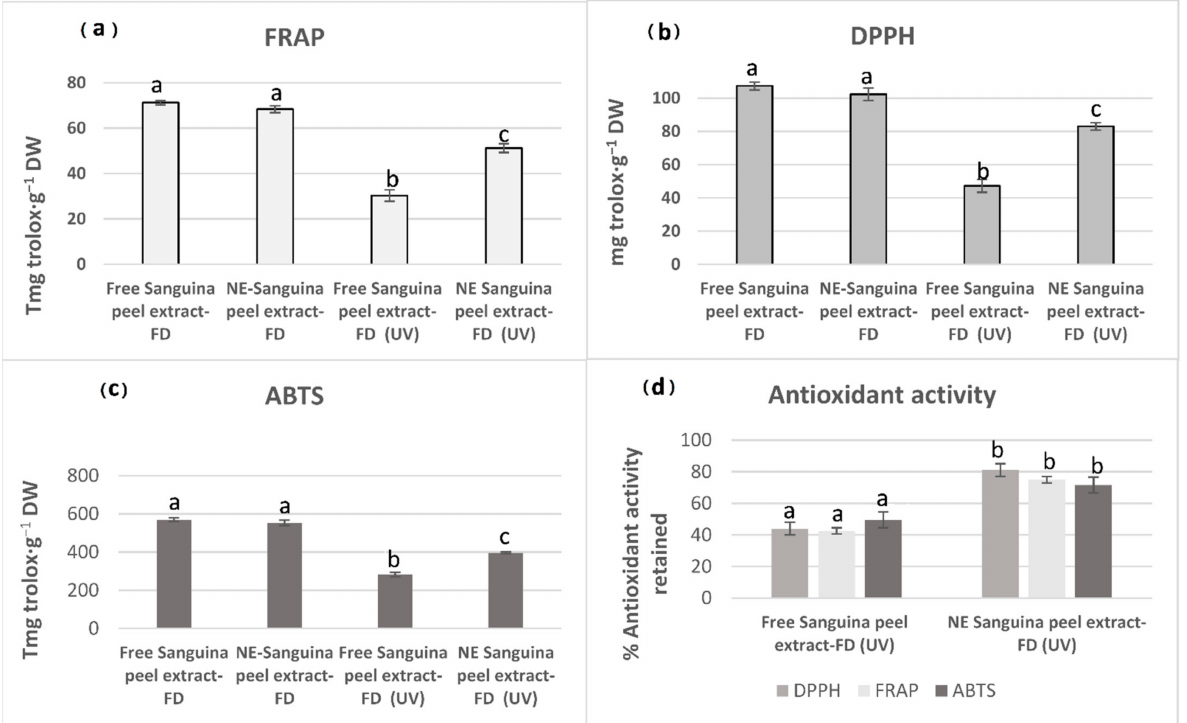
Figure 6. Antioxidant activity DPPH ( a ); FRAP ( b ); and ABTS ( c ) of pressurized extracts from free FD Sanguina peel in comparison with nanoemulsion of Sanguina peels FD, after 60 min of UV lamp oxidation. ( d ) shows the percentage of the antioxidant activity retained by NE vs. free extract after the UV